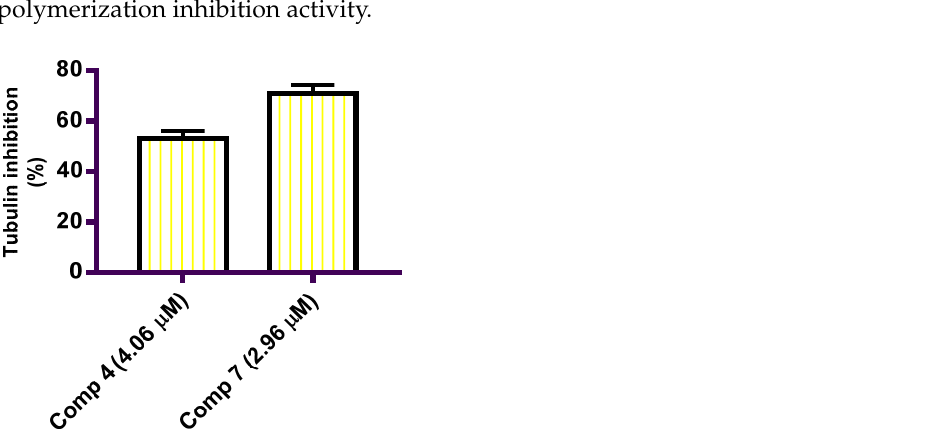
at their IC 50 ( µ Figure 3. Graphical representation of tubulin polymerization inhibition effect of compounds 4 and 7 at their IC 50 ( μ M).